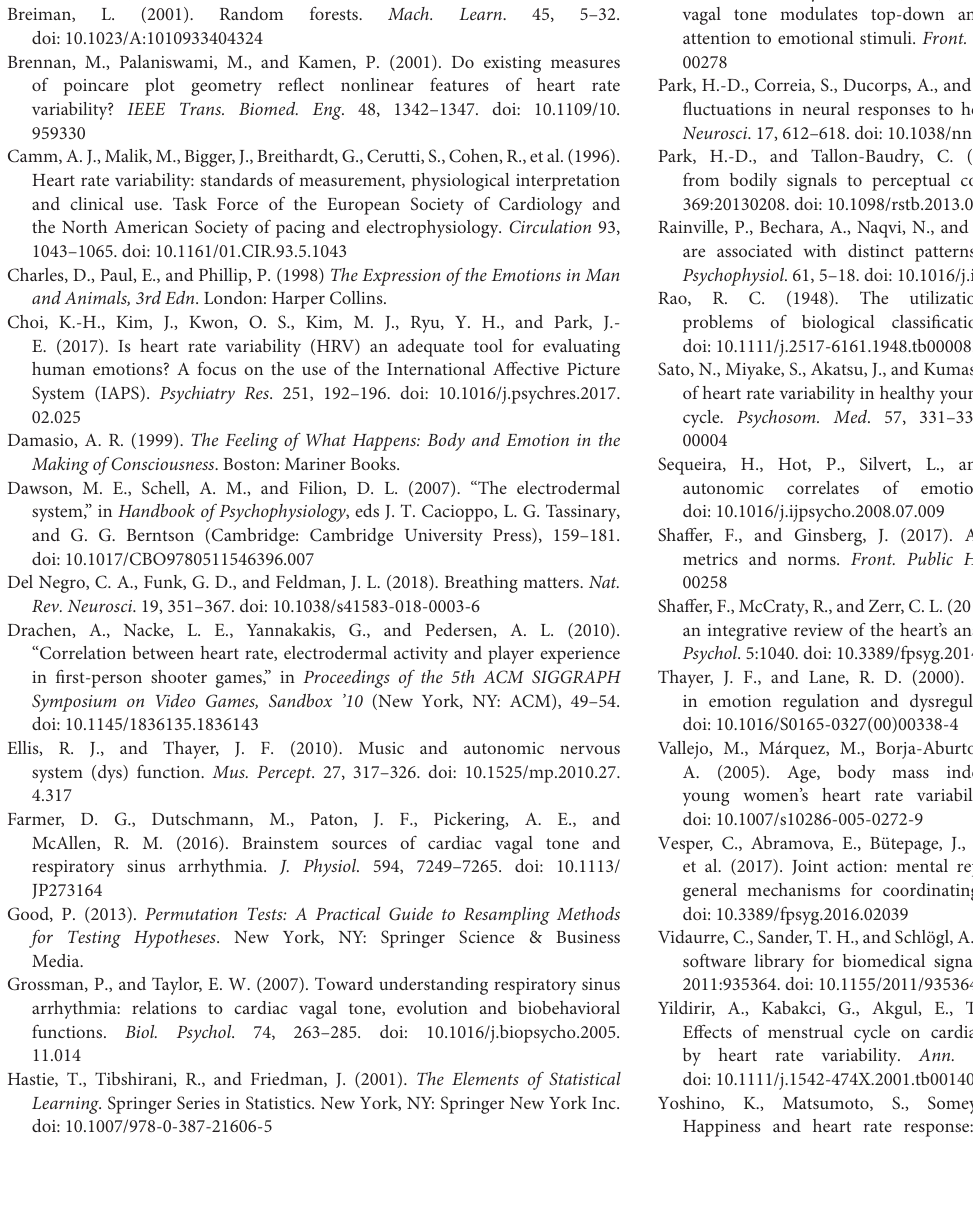
Frontiers in Human Neuroscience |